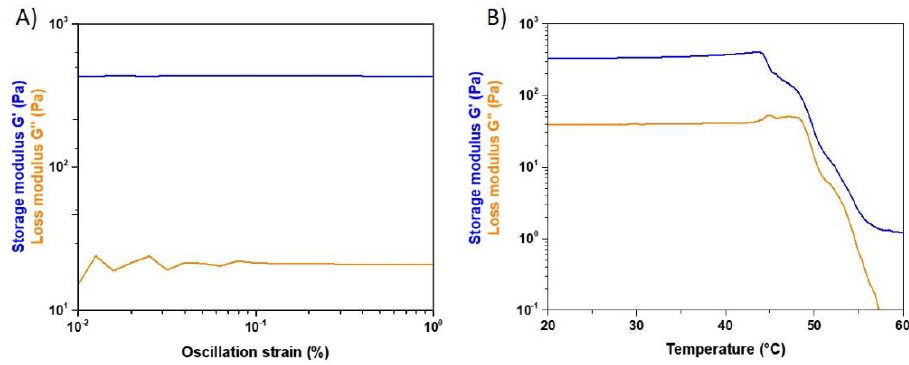
Figure 4. Amplitude sweep test ( A ) and temperature ramp ( B ) performed on Coll/MBG_Sr4% samples.